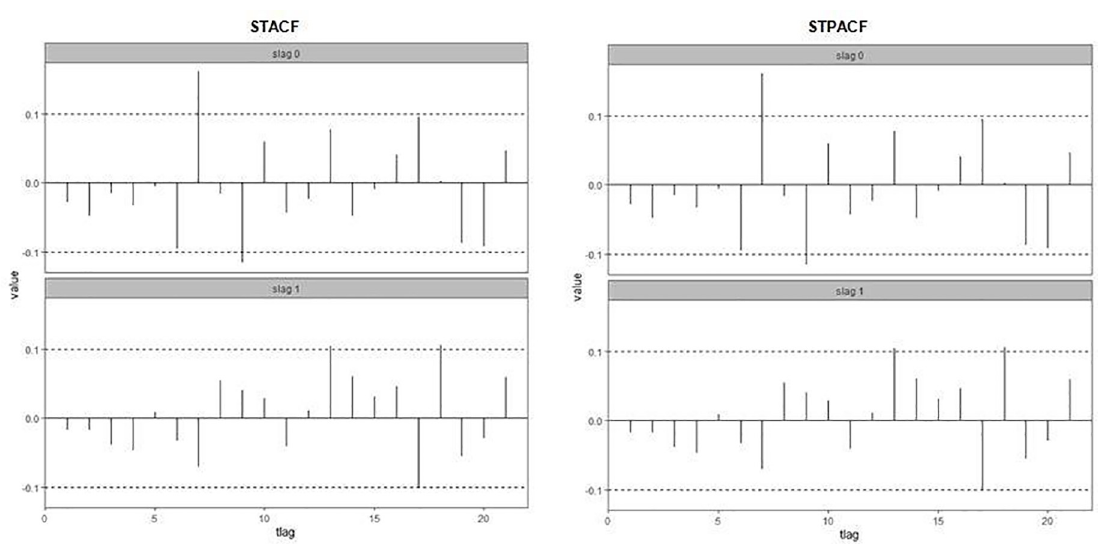
Fig 7. STACF and STPACF of STARIMA (1 0 ,1,1 1 )